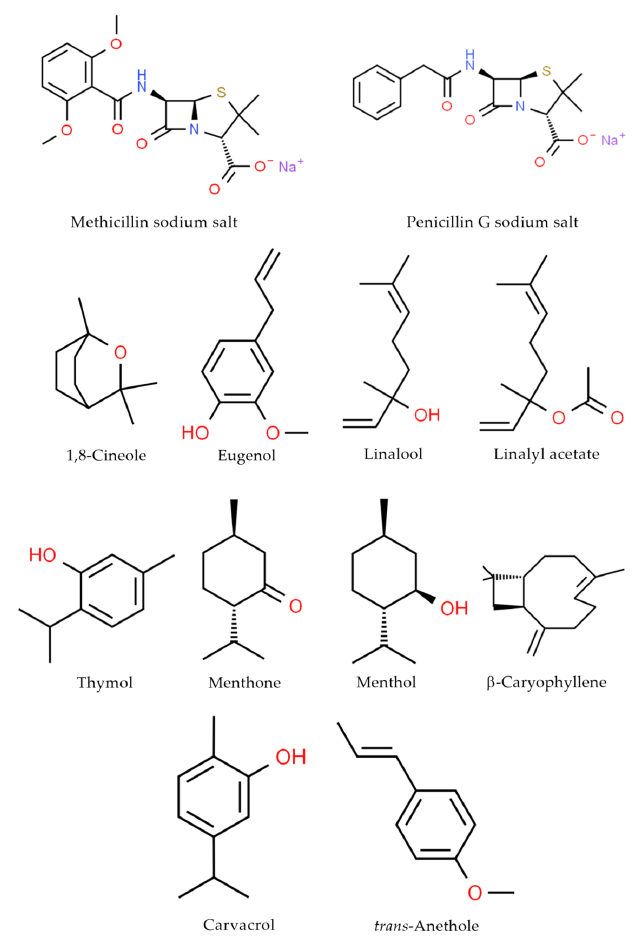
Figure 4. Chemical structures of the compounds used in this study.